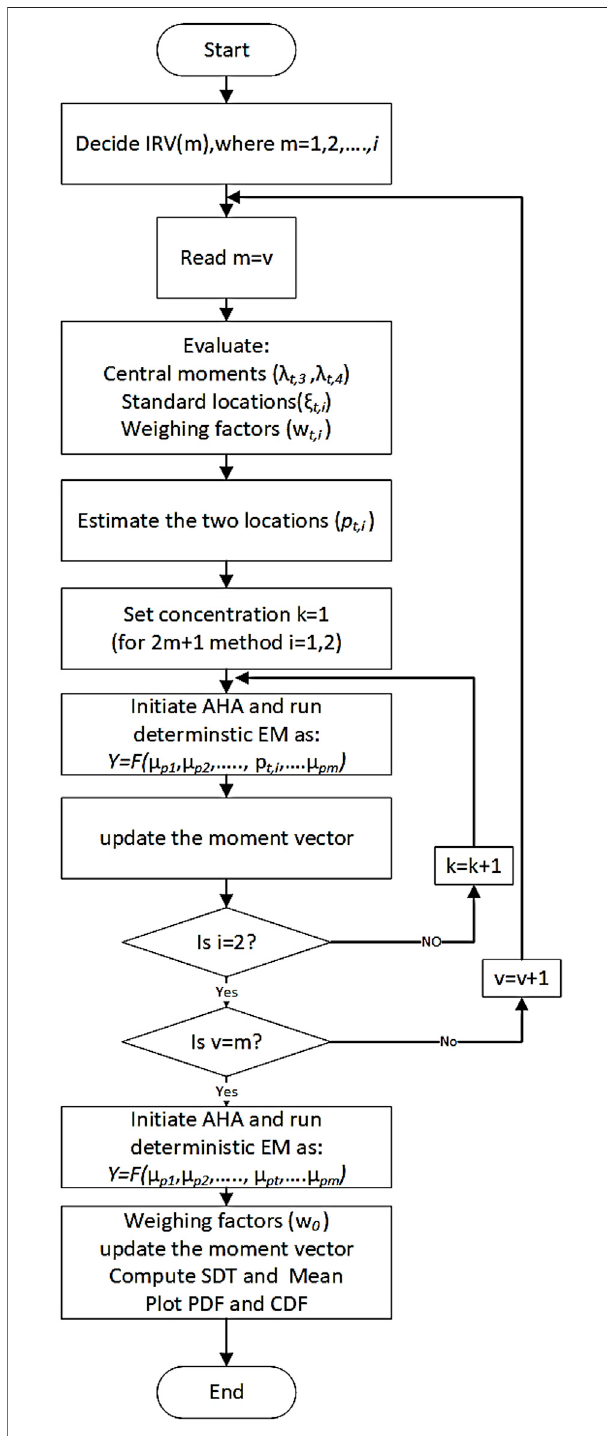
FIGURE 2 | Flow chart of proposed